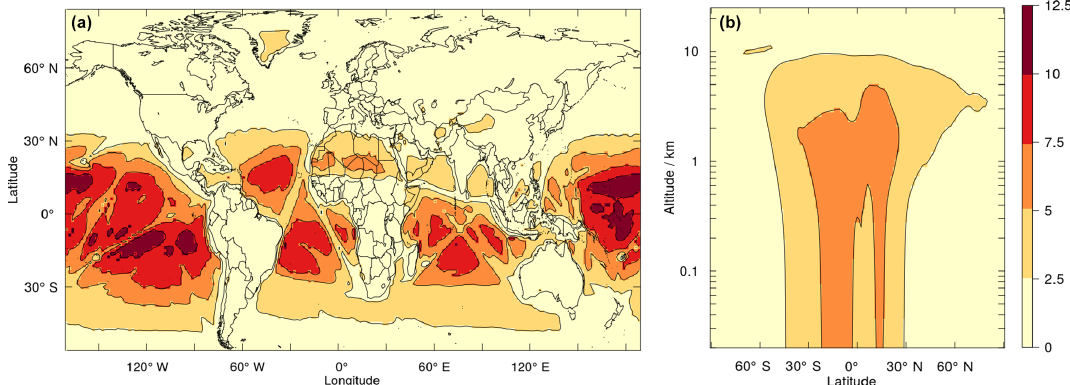
Figure 11. Annual mean percentage change in HO 2 concentrations from run 1 (relative to the base run) at the surface (a) and as a zonal mean (b) .